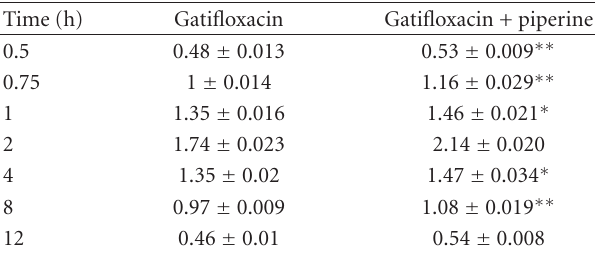
Table 18: Comparison of pharmacokinetic parameters of atenolol- and atenolol + piperine-treated male New Zealand white rats after single oral administration (100 mg/kg)